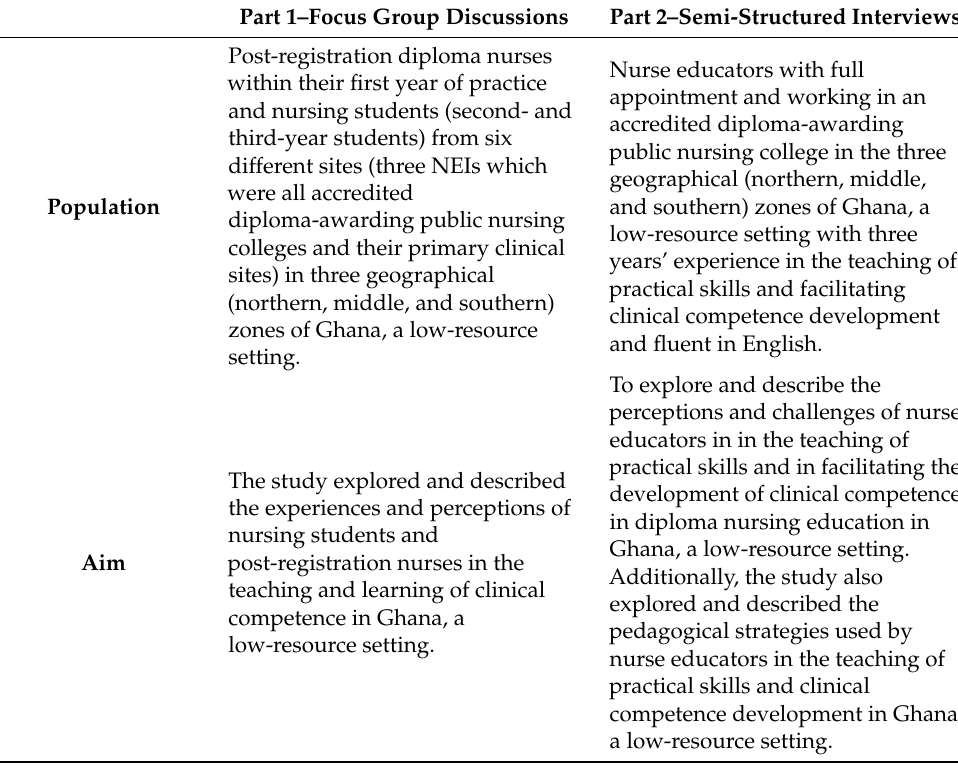
Table 1. Situational analysis–qualitative descriptive